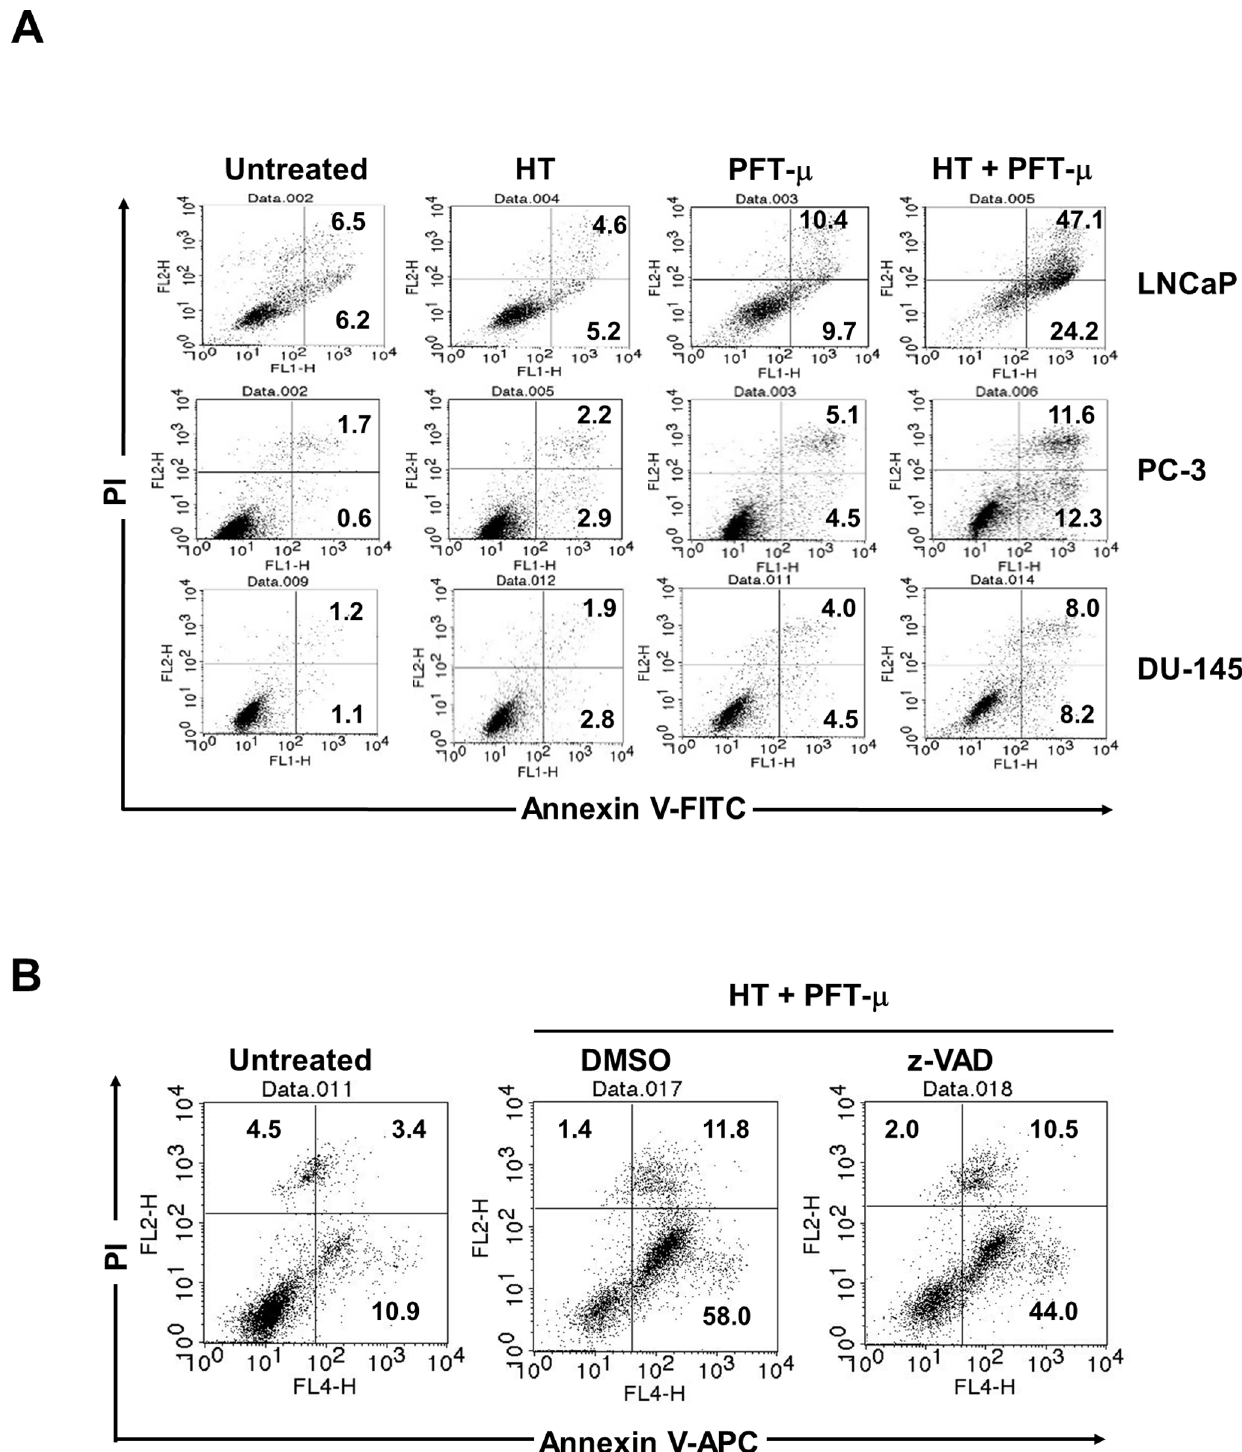
Figure 4. Cancer cell death after combination therapy with HT and PFT- m . ( A ) Three cell lines were treated with HT (43 u C for 2 h) and/or PFT- m . After 48 h, flow cytometry was performed after staining with FITC-conjugated Annexin V and PI. A representative result is shown. The numbers represent the percentages of each subset. ( B ) LNCaP cells were treated with both HT and PFT- m (5 m M) in the presence of z-VAD (20 m M) or control DMSO. After 48 h, flow cytometry was performed after staining with APC-conjugated Annexin V and PI. The numbers represent the percentages of each subset.